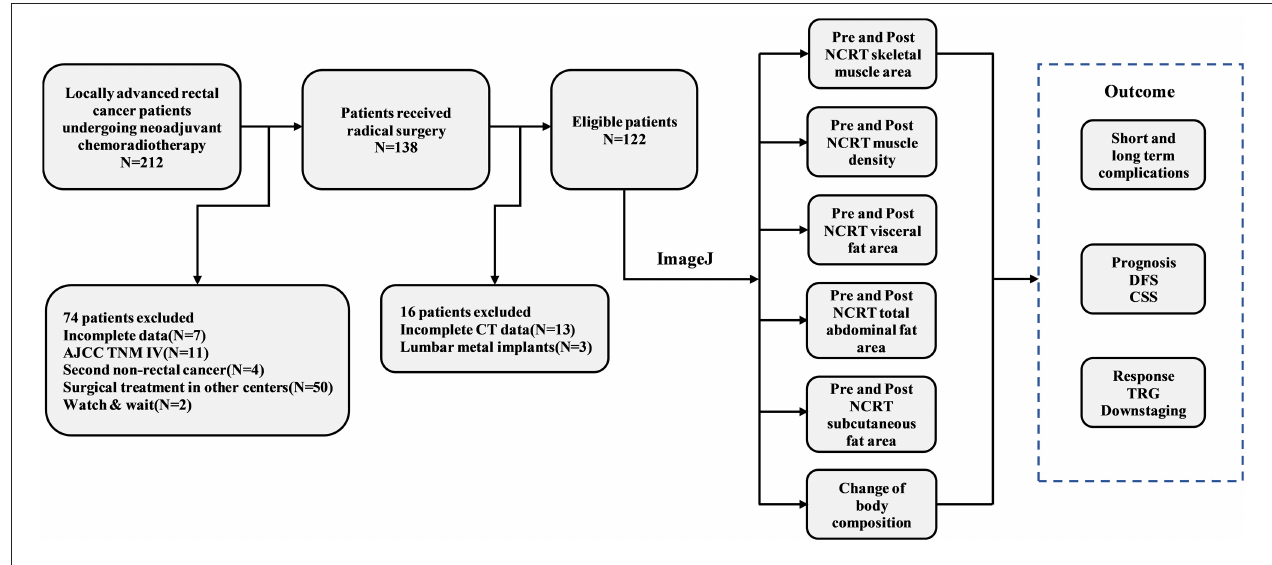
FIGURE 1 | Flow chart of the study.